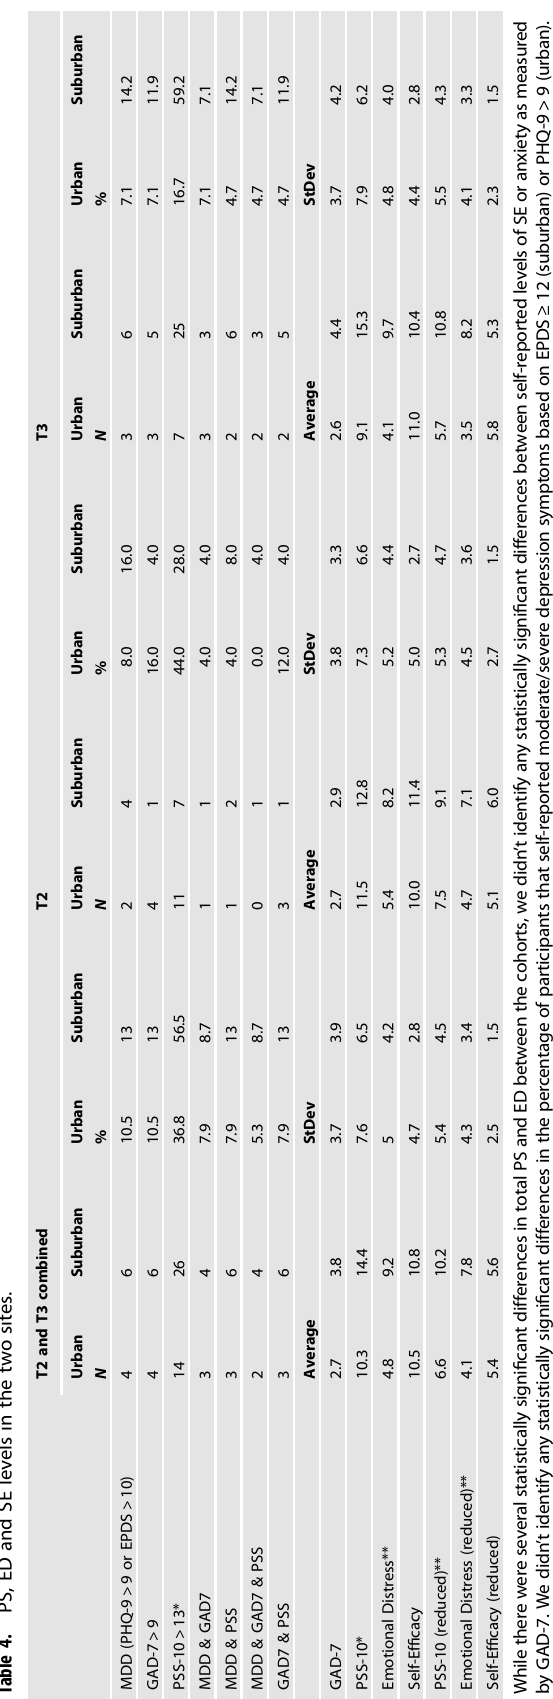
(Table 1). While PSS-10 could be explained by a two factor model as previously reported [17] (Fig. S1a, Table S1), the con fi rmatory factor analysis (CFA) indicated that the loading of the PSS-10 items in each factors, ED and SE, were very distinct between the two cohorts (Table 2, Fig. S1b, c). Using an iterative step approach, we removed an item at a time to arrive to a signi fi cant reduced PSS-10 with seven total items. The strict two-factor model of the reduced PSS-10 was signi fi cant (Fig. S2a, Table S2) and was strictly invariant between the urban and suburban cohort (Table 3). The items removed from PSS-10 to render an invariance model were item f from the ED factor ( ‘ In the last month, how often have you found that you could not cope with all the things that you had to do? ‘ ) and items e and h from the SE factor ( ‘ In the last month, how often have you felt that things were going your way? ’ ; ‘ In the last month, how often have you felt that you were on top of things? ’ ). than the urban women in the third trimester and overall, but we didn ’ t observe any differences in rSE between the cohorts or trimesters (Table 4). Participants from the urban cohort reported lower levels of PS and ED (PSS-10 subconstruct) (Table 4). In addition, the ratio ED and SE showed differences between the two cohorts with the urban participants reporting lower levels of ED in relation to SE compared with the suburban participants (Fig. S2). Yet there were similar levels of SE (PSS-10 subconstruct) in both cohorts and across race/ethnicity (Table 4, Fig. 1). PS, ED and SE are associated with the gut microbiota relative abundance but not with immune factors While we didn ’ t observe any signi fi cant differences in microbial community structures (alpha- and beta-diversity and volatility) and reported levels of rPS, rED and rSE levels (Figs. S3 – S7), 10 amplicon sequence variances (ASVs) were signi fi cantly associated with rPS, rED and rSE levels and with the Ratio between rED and rSE independently of the recruitment location (Fig. 2). For instance, Bacteroides uniformis and Terrisporobacter mayombei T a